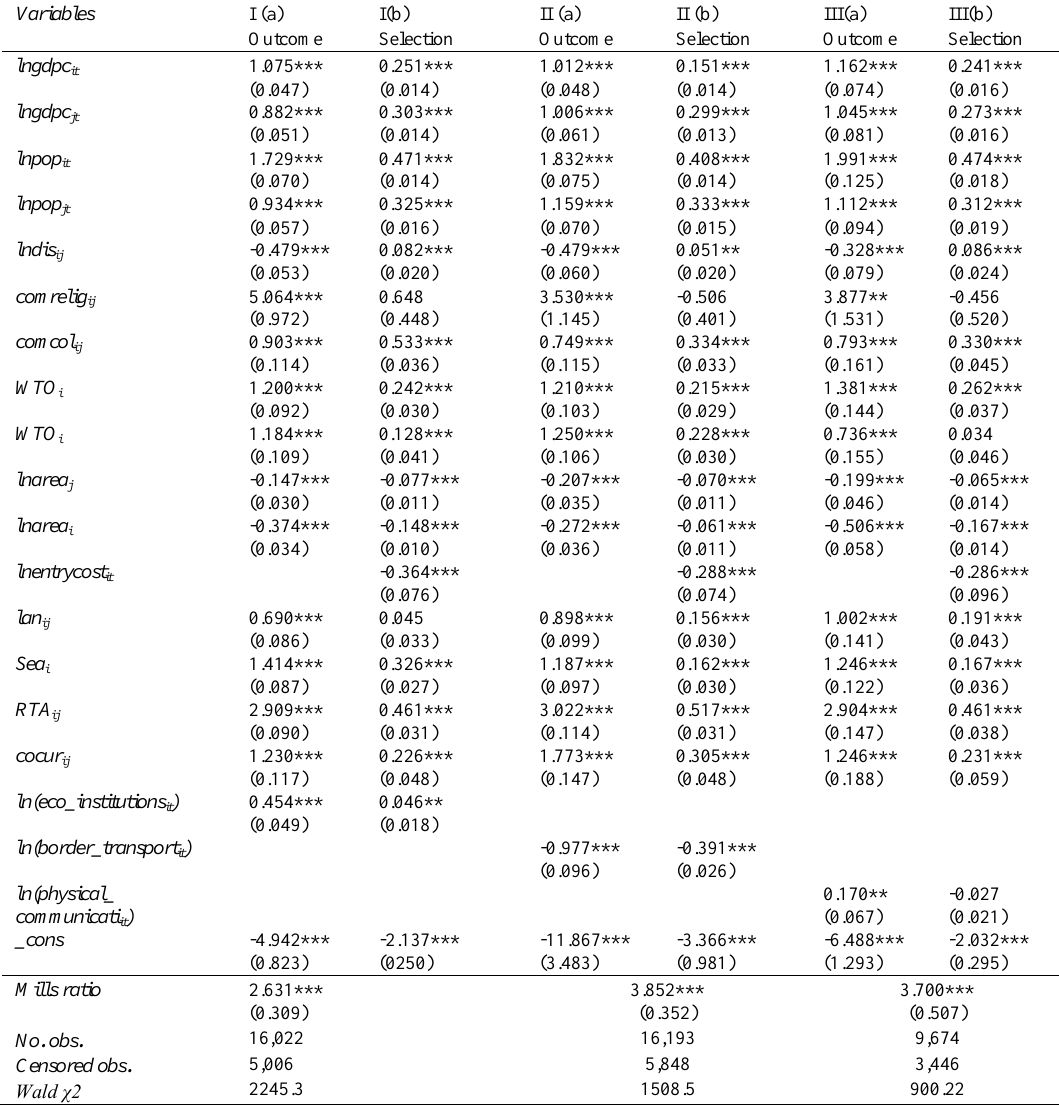
Table 2 : The impacts of border and transport efficiency, quality of economic institutions, physical and communication infrastructure on intra-Africa